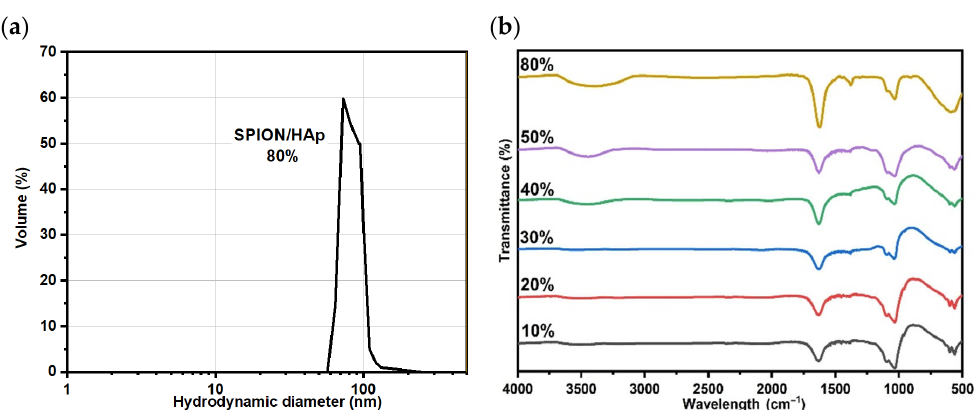
Figure 11. ( a ) DLS analysis of SPION/Hap and ( b ) FT-IR spectra of nanocomposite with different ratio SPION/HAp at 80 °C with pH 11.